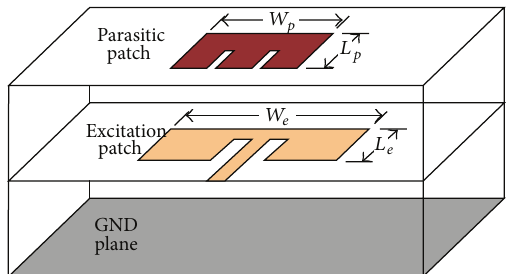
Figure 1: Stacked patch antenna having excitation patch ( 𝐿 𝑒 = 8 mm, 𝑊 𝑒 = 18 mm) with inset ( 𝐿 = 6 mm, 𝑊 = 1.1 mm) and Parasitic patch ( 𝐿 𝑝 = 7.2 mm, 𝑊 𝑝 = 10 mm) with inset ( 𝐿 = 3.5 mm, 𝑊 = 0.5 mm).